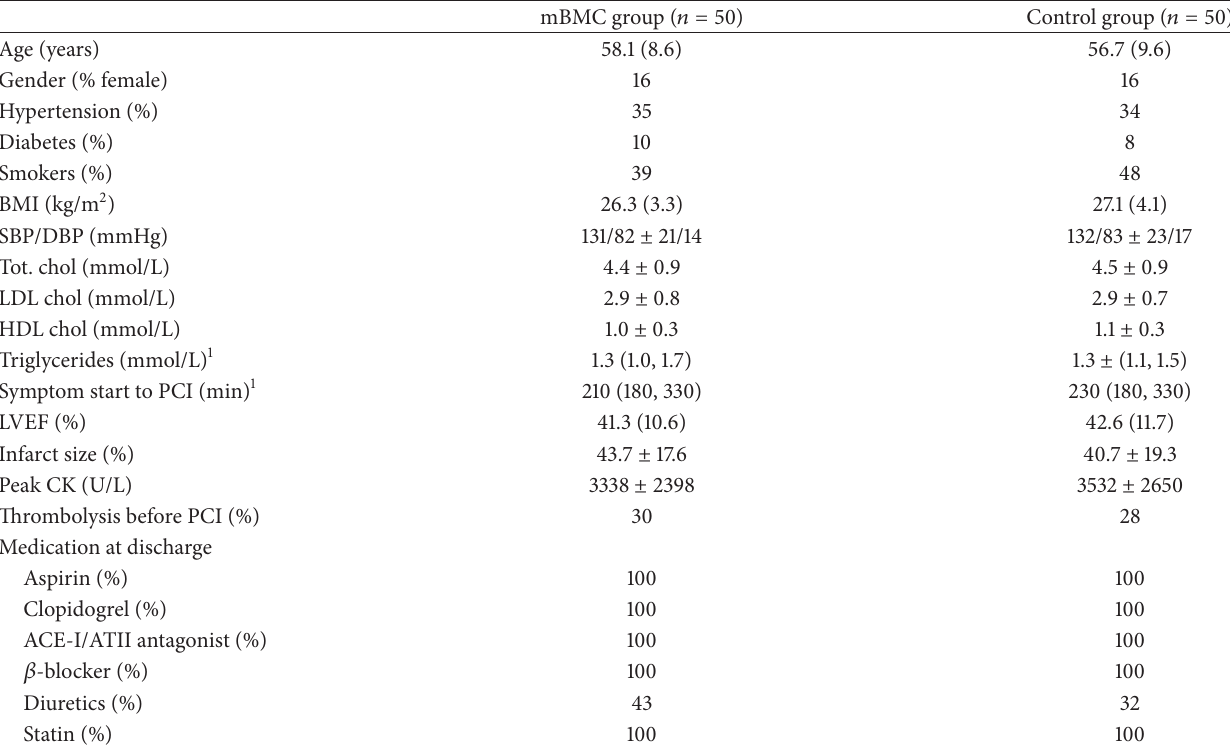
Table 1: Characteristics of the study population according to the randomized groups. Values are presented as proportion, means ± SD, or medians 1 with 25th and 75th